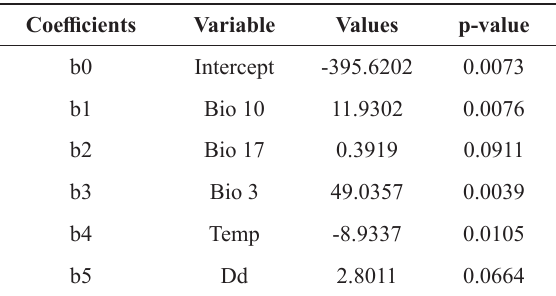
Coefficients estimated by the regression model and their statistical